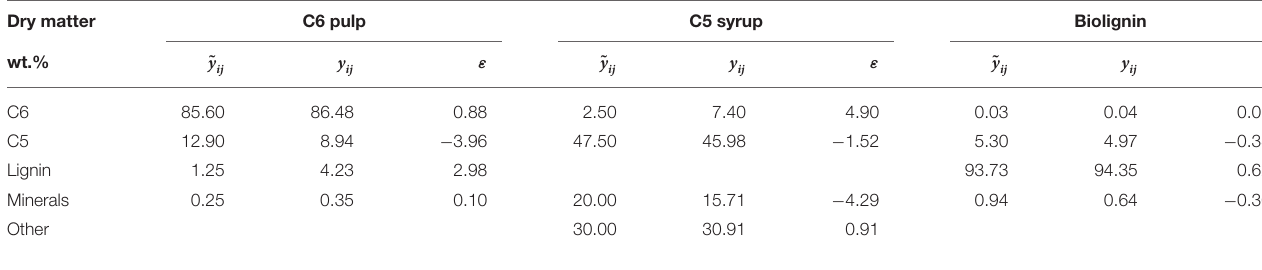
TABLE 1 | Results for the product streams (wheat